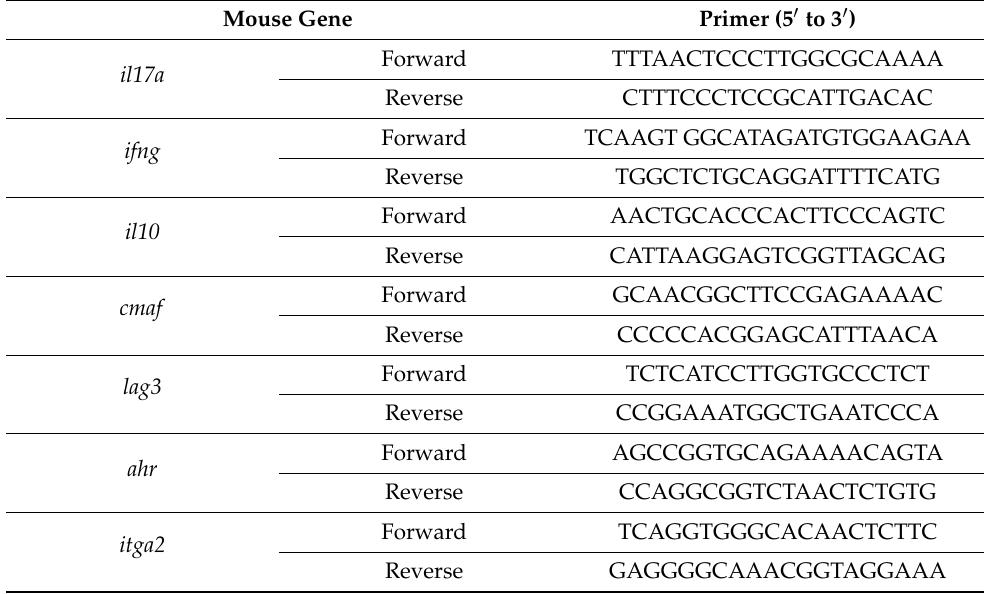
Table 1. Forward and reverse primers. Primers are shown for each gene analyzed by real-time PCR. Mouse